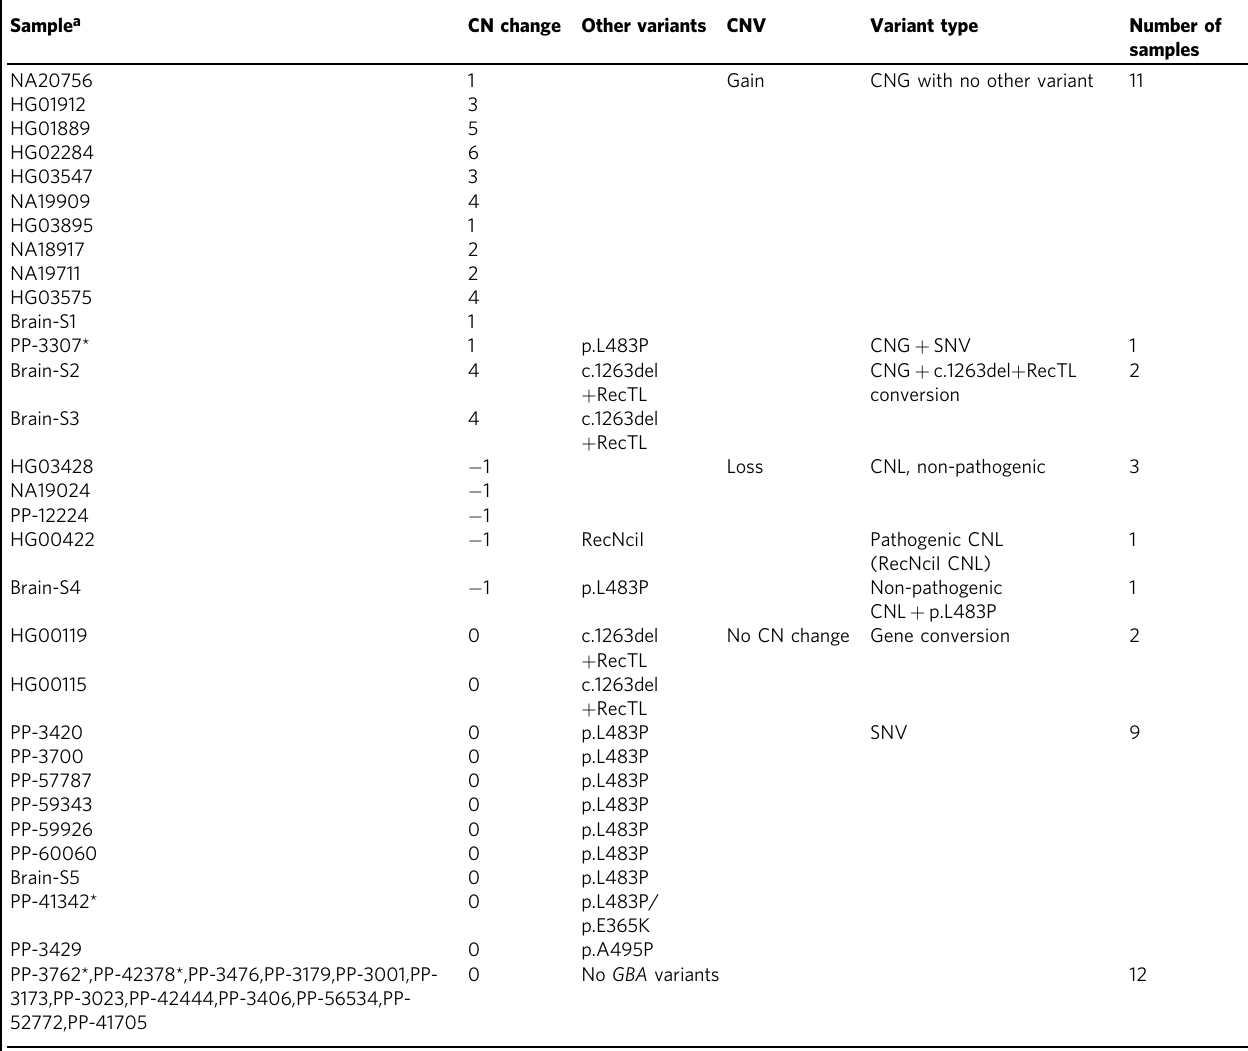
Table 1 Details of cross-validation between Gauchian and ONT. Sample a